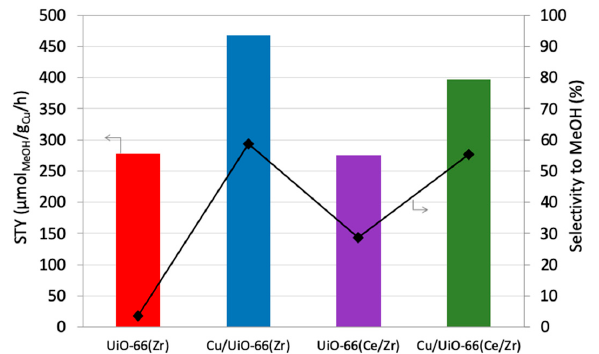
Figure 10. Selectivity to MeOH and space time yield over UiO-66 and Cu/UiO-66 materials after 25 h of catalytic tests.